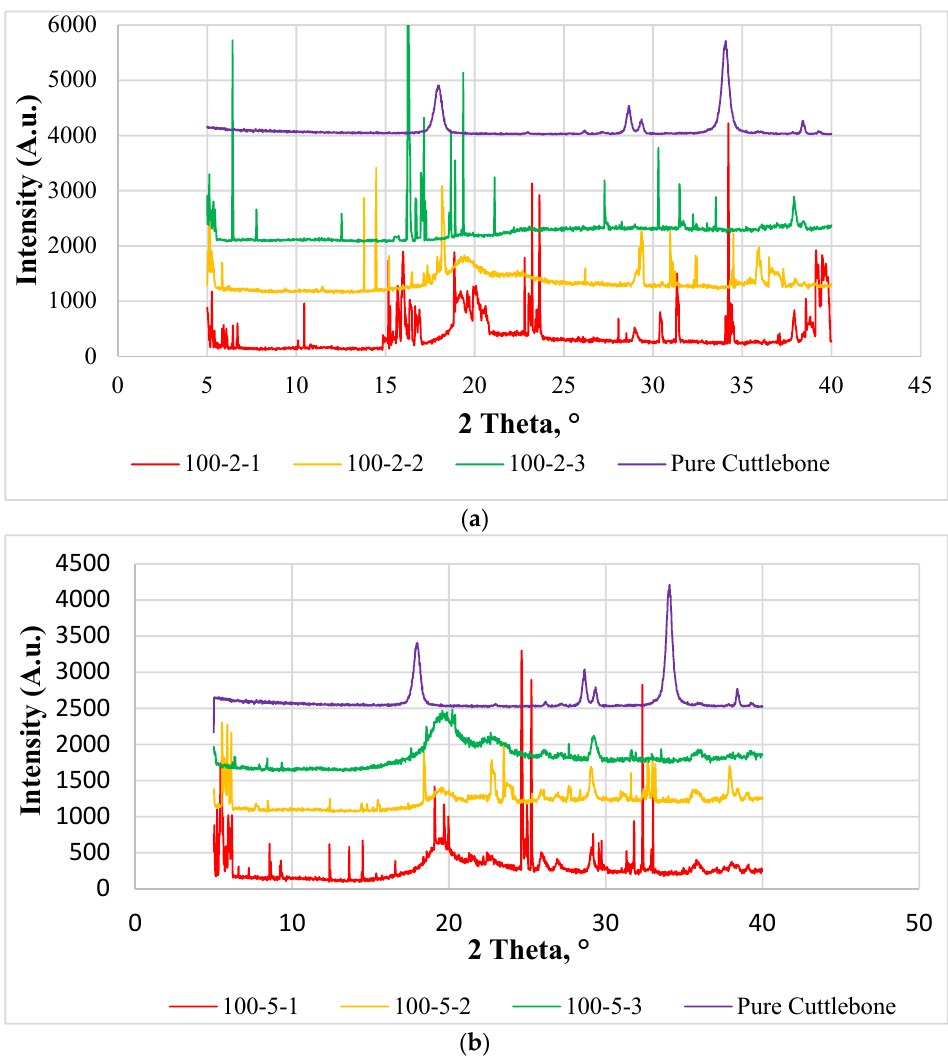
Figure 7. XRD curves (5° ≤ 2 θ ≤ 40°) for ( a ) pure calcined cuttlebone and PVOH added with 2 phr of calcined cuttlebone and various loading levels of MMT, and ( b ) pure calcined cuttlebone and PVOH added with 5 phr of calcined cuttlebone and various loading levels of MMT. Note: 100-5-1 denotes 100 phr PVOH added with 5 phr cuttlebone and 1 phr MMT; others followed this notation as well.